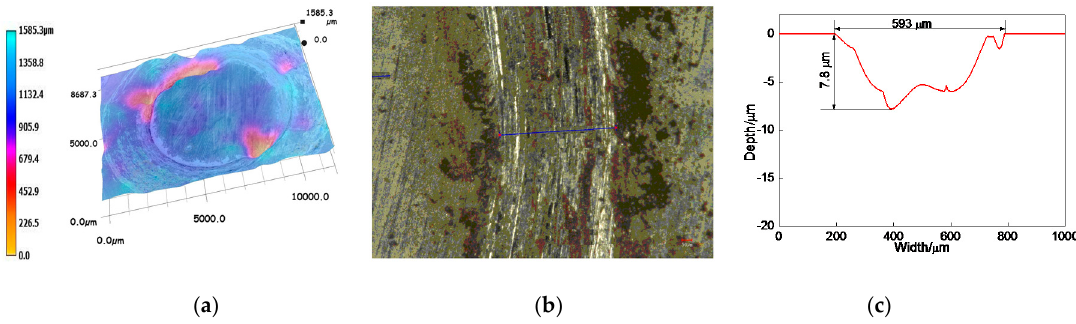
Figure 14. Profile of worn track on 24% Cr–76% Ni coating. ( a ) Overall profile of worn track; ( b ) Measured position of worn track; ( c ) Profile of worn track.